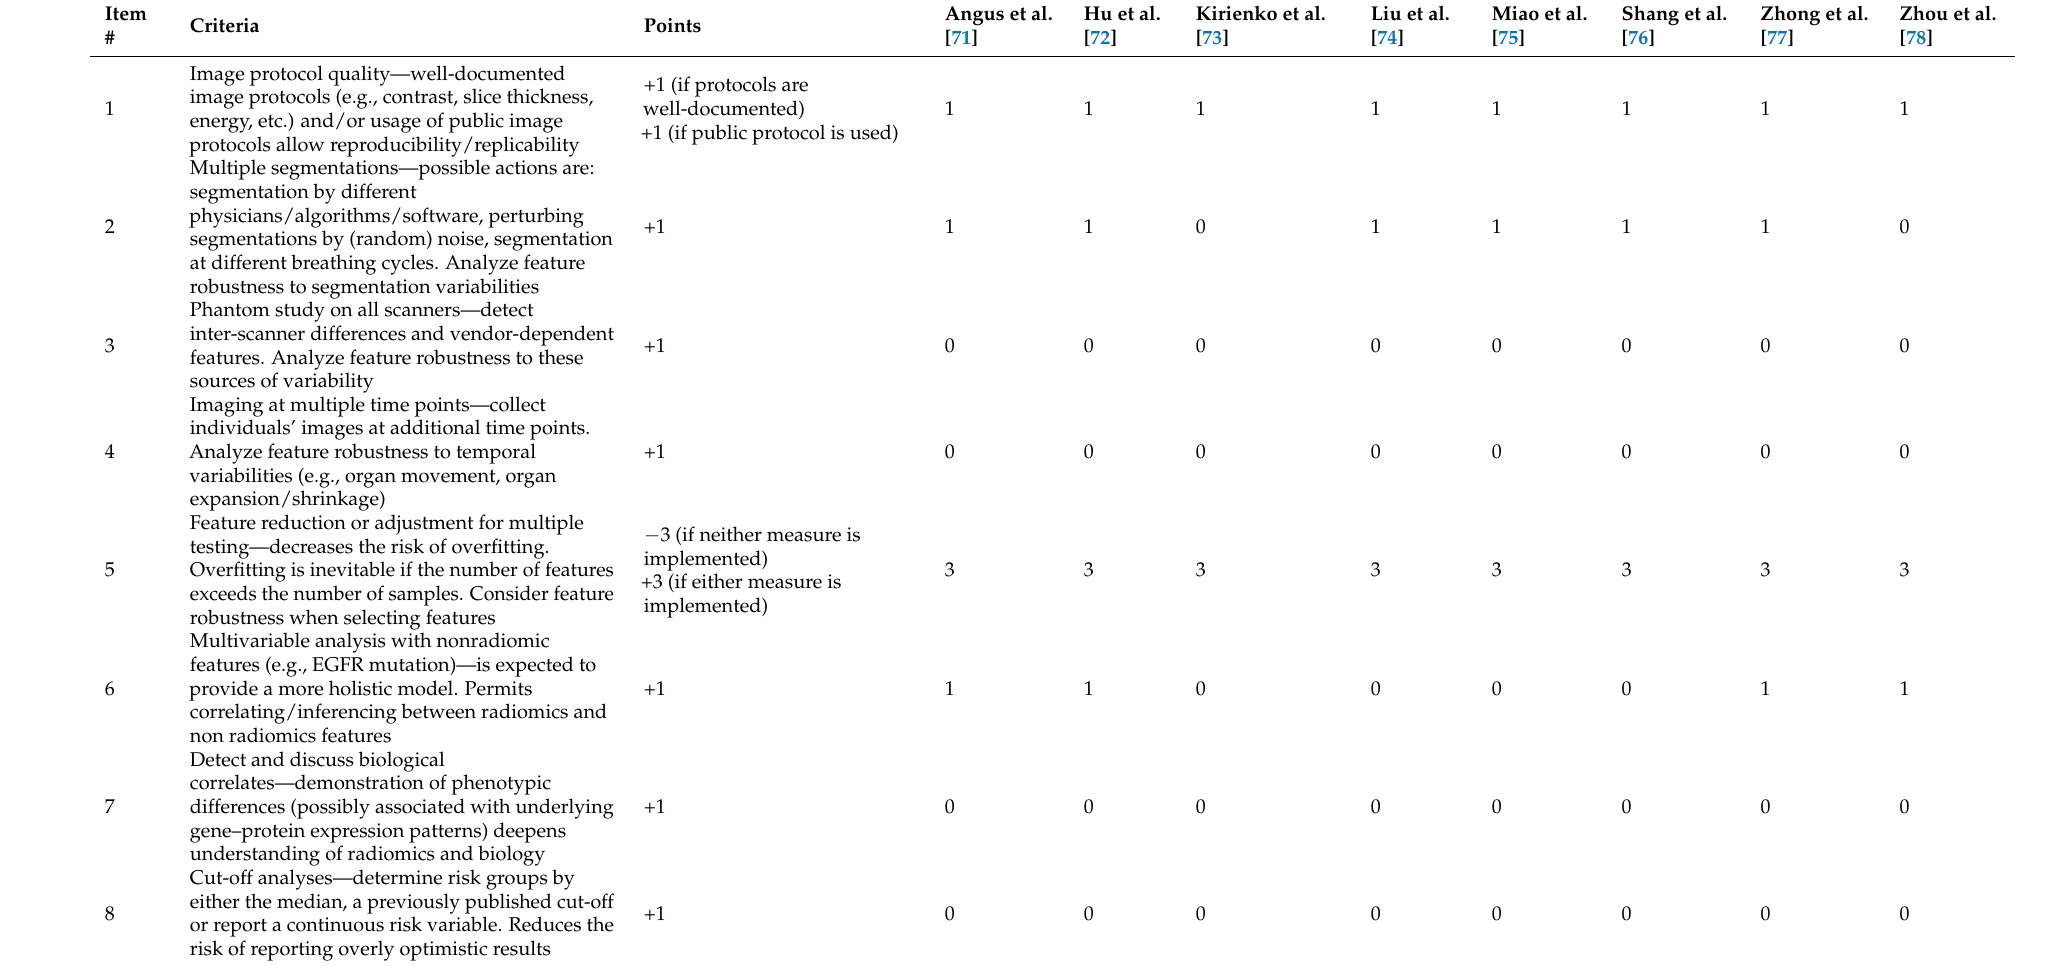
Table 2. RQS calculation for the 8 articles selected, based on the criteria illustrated by Lambin et al.